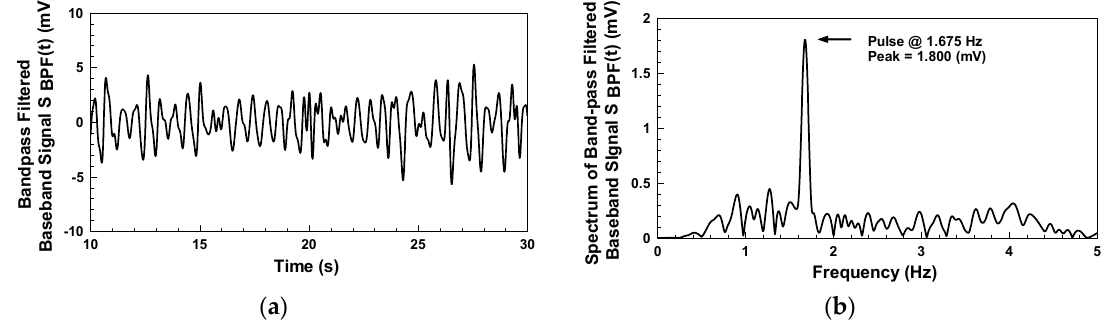
Figure 10. Pulse detection results for the subject wearing a short-sleeved shirt: ( a ) Bandpass-filtered baseband signal; ( b ) Spectrum of Figure 10a. Biosensors 2016 , 6 , 54